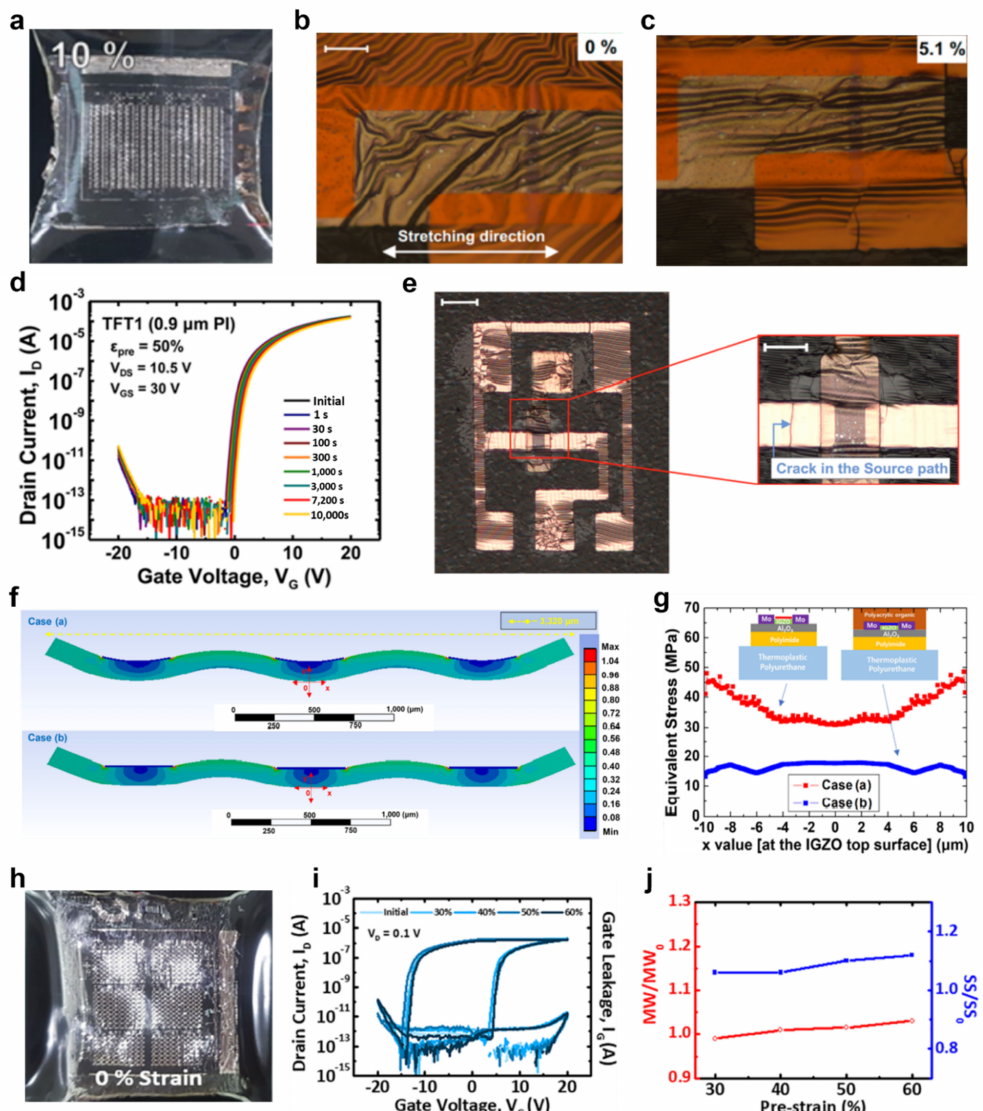
Figure 3. ( a ) Photograph of the IGZO TFT device at strain condition; ( b ) The evolution of wrinkles at different stretching values is shown (0%); ( c ) The evolution of the wrinkles at different stretching values is shown (5.1%); ( d ) Transfer curve during the PBS tests with a lapse of stress time in pre- strain of 50% (adapted from [60] with permission from American Chemical Society); ( e ) Crack formation near its channel region in strain values above 5% (scale bar: 50 µ m) (adapted from [62] with permission from American Chemical Society); ( f ) Stretching simulation without and with an organic passivation layer; ( g ) Horizontal equivalent (Von Mises) stress distributions in the stretched state (adapted from [63] with permission from American Chemical Society); ( h ) Photograph of device surface under a mechanically stretching situation; ( i ) Transfer characteristics of the stretchable TFTs when pre-strain values were varied up to 60%; ( j ) Variations in MW and SS as a function of pre-strain value (adapted from [64] with permission from American Chemical